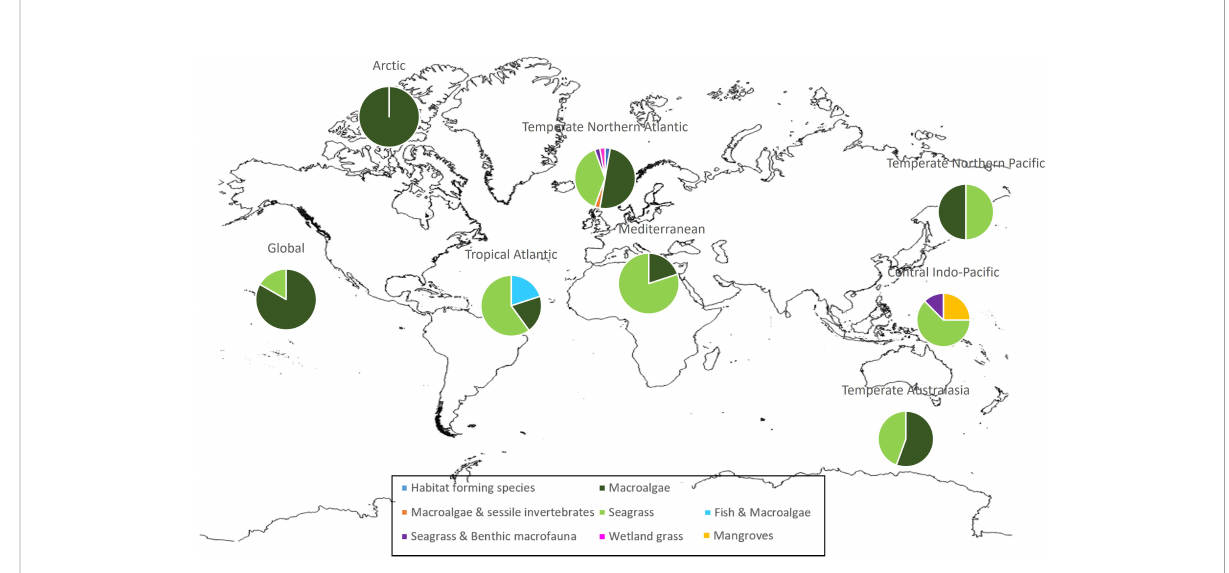
FIGURE 2 Proportion of taxa studied in HSM publications divided by geographical